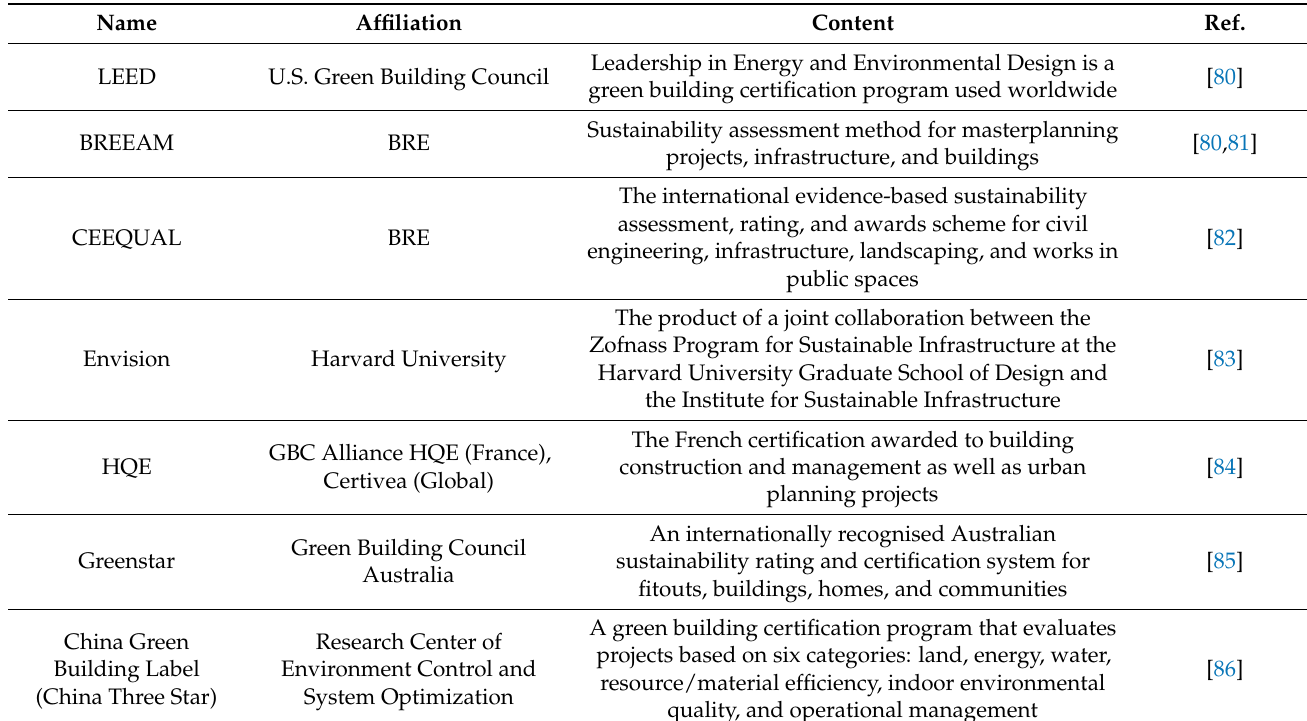
Table 5. Summary of rating